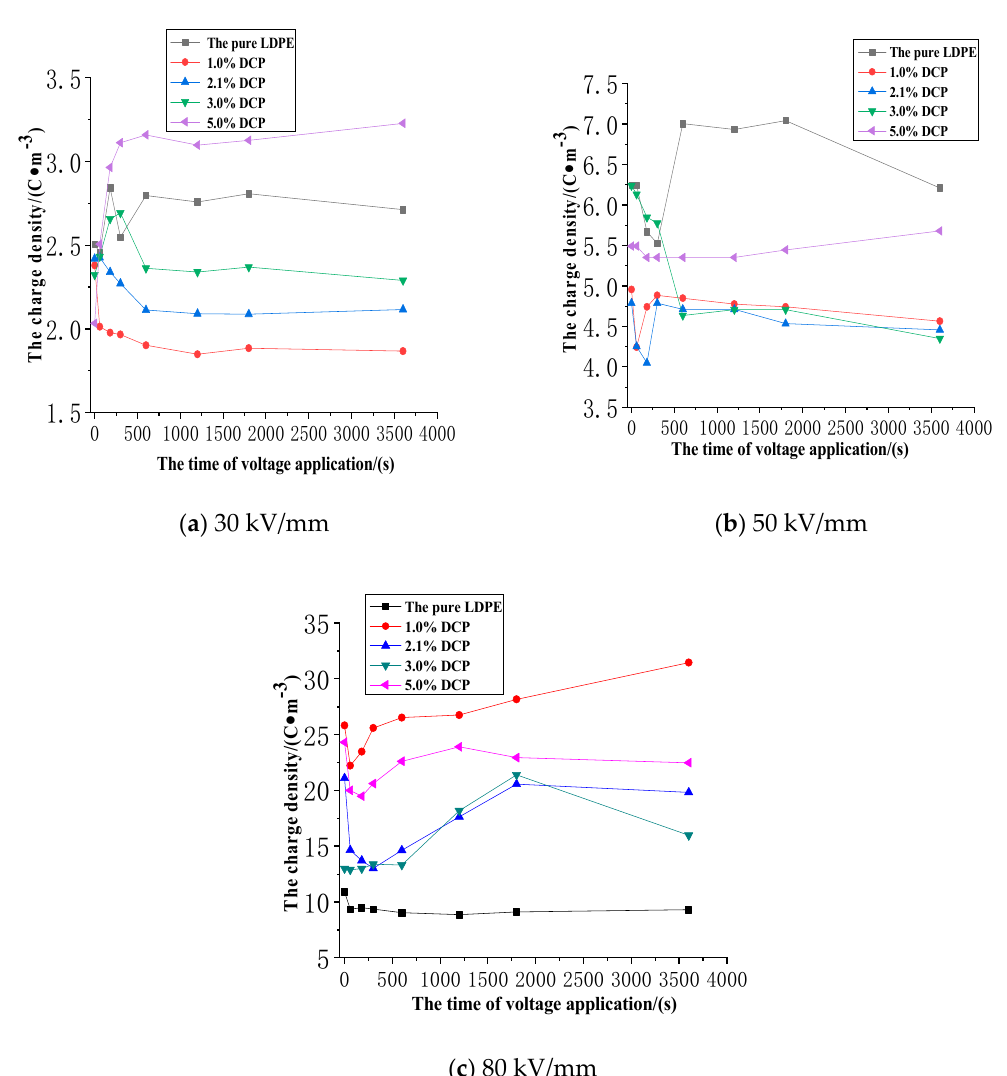
Figure 10. The average charge density of each unaged sample in the applied voltage experiment of different electric field strengths with the time of voltage application. ( a ) The experimental results at the electrical field strength of 30 kV/mm. ( b ) The experimental results at the electrical field strength of 50 kV/mm. ( c ) The experimental results at the electrical field strength of 80 kV/mm.